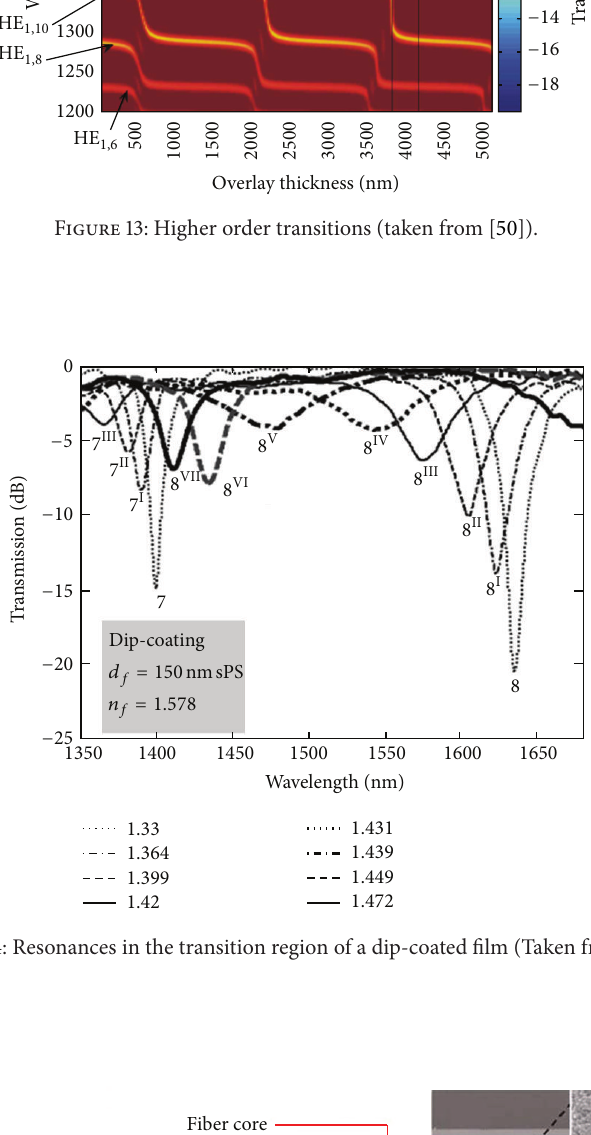
TiO 2 nanoparticles